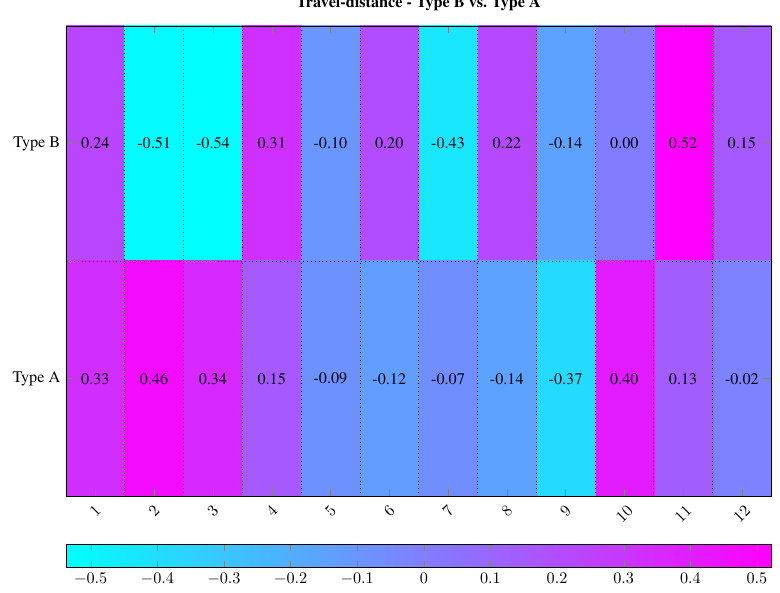
Figure 6. Comparison